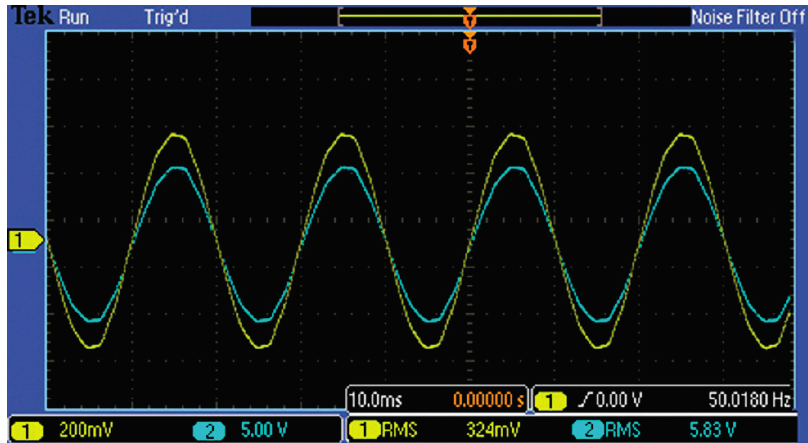
Figure 11. 10/ 3 kV AC voltage waveform comparison.